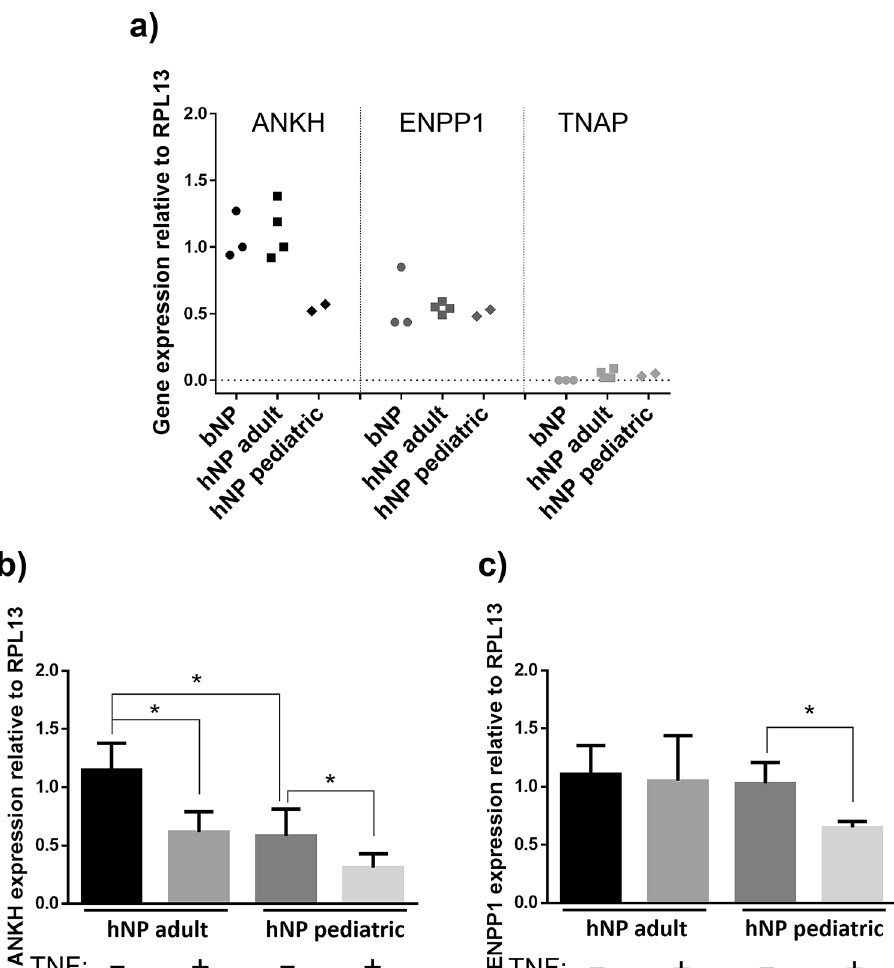
Figure 1. TNF down-regulates ANKH and ENPP1 expression in human NP cells. ( a ) Gene expression of ANKH, ENPP1 and TNAP in primary bNP and primary hNP cells obtained from pediatric and adult patients; ( b ) effect of 20 ng/mL TNF treatment on ANKH and ( c ) ENPP1 gene expression in hNP (n = 4). Significance represents p < 0.05. Data analyzed using one-way